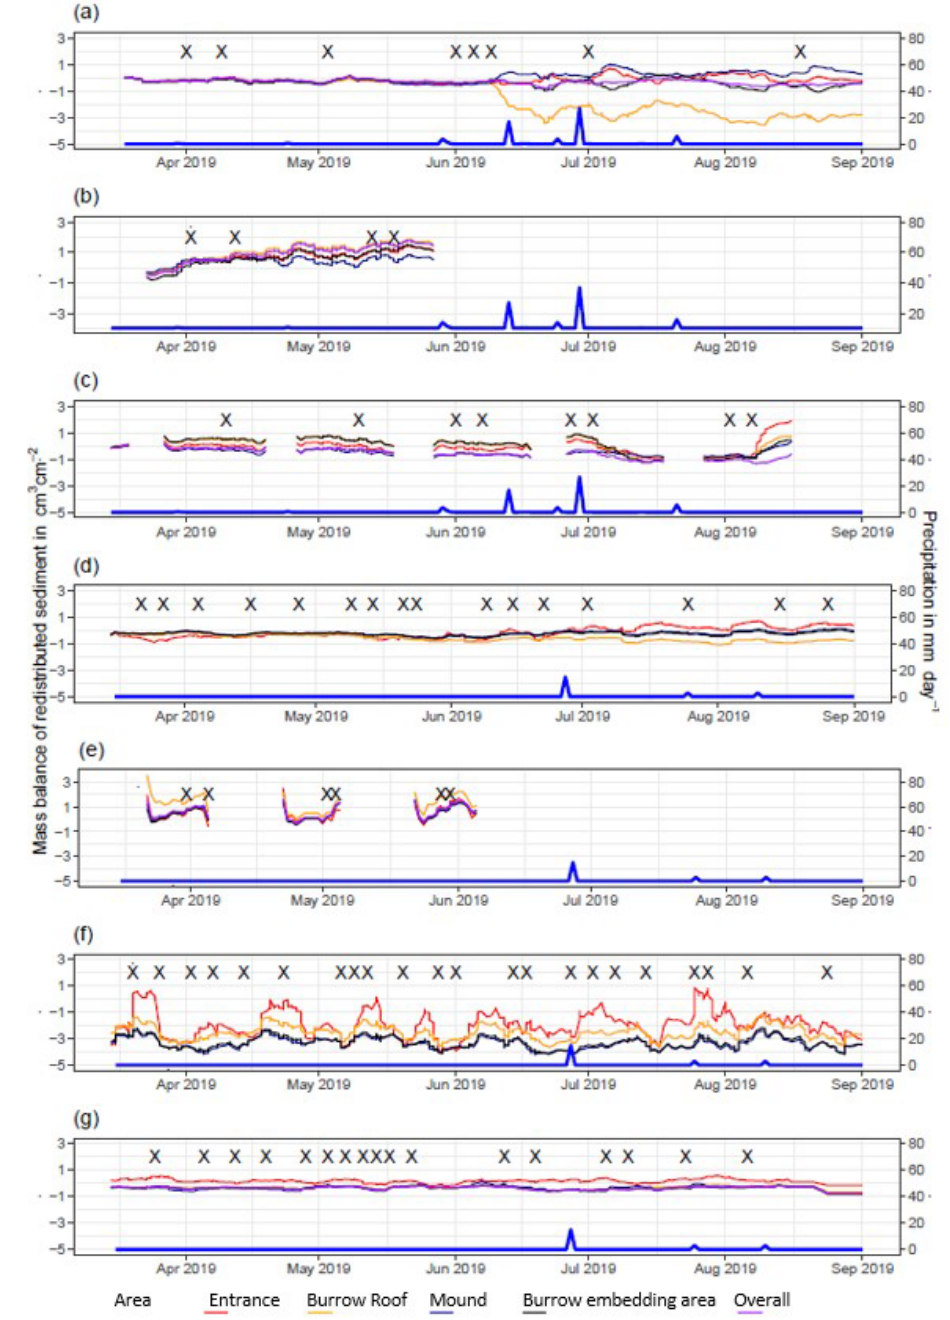
Figure A5. Sediment mass balance for the period of 7 months shown separately for all delineated areas as measured by the cameras: